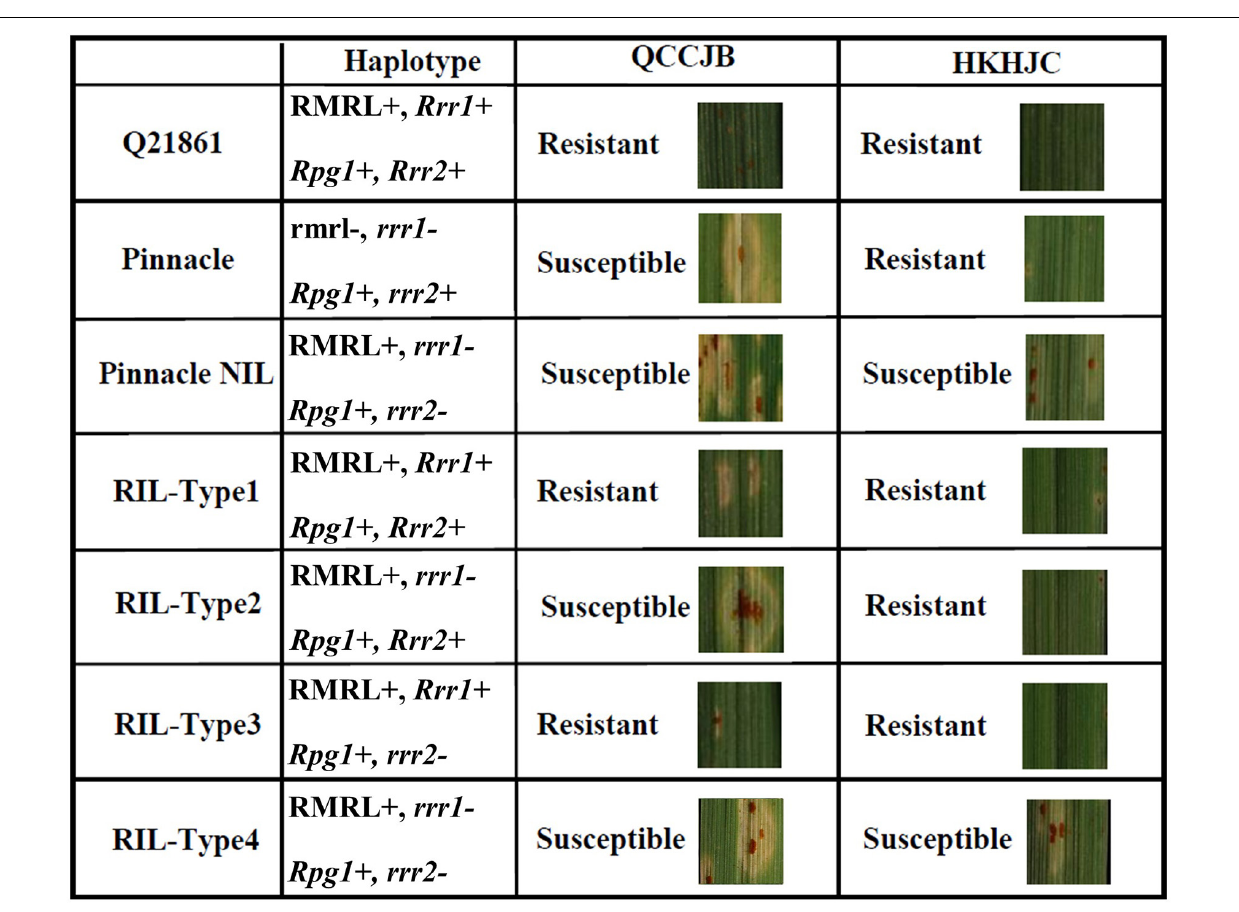
FIGURE 6 | Seedling assay using Pgt race QCCJB and HKHJC showing disease response on barley containing different combination of RMRL, Rpg1 , Rrr1 and Rrr2 alleles. QCCJB is virulent on Rpg1 and HKHJC is virulent on RMRL. Pinnacle is the recurrent parent and Q21861 is the RMRL donor of the Pinnacle RMRL-NIL. Four different allelic combinations of the two additional genes required for stem rust resistance, Rrr1 and Rrr2 , occur in the Pinnacle RMRL-NIL/Q21861 progeny. Rrr1 is required to confer RMRL mediated QCCJB resistance (Q21861, RIL-Type1 and RIL-Type2). Rpg1 mediated resistance is independent of Rrr1 and Rrr2 in absence of RMRL (Pinnacle). The introgression of RMRL into the Pinnacle background necessitates the presence of either a functional Rrr1 or Rrr2 to confer Rpg1 mediated HKHJC resistance (Q21861, RIL-Type1, RIL-Type2, RIL-Type3). Rpg1 mediated HKHJC resistance in RIL-Type2 and RIL-Type3 shows that Rrr1 and Rrr2 have a complementary gene function in the Rpg1 -mediated resistance